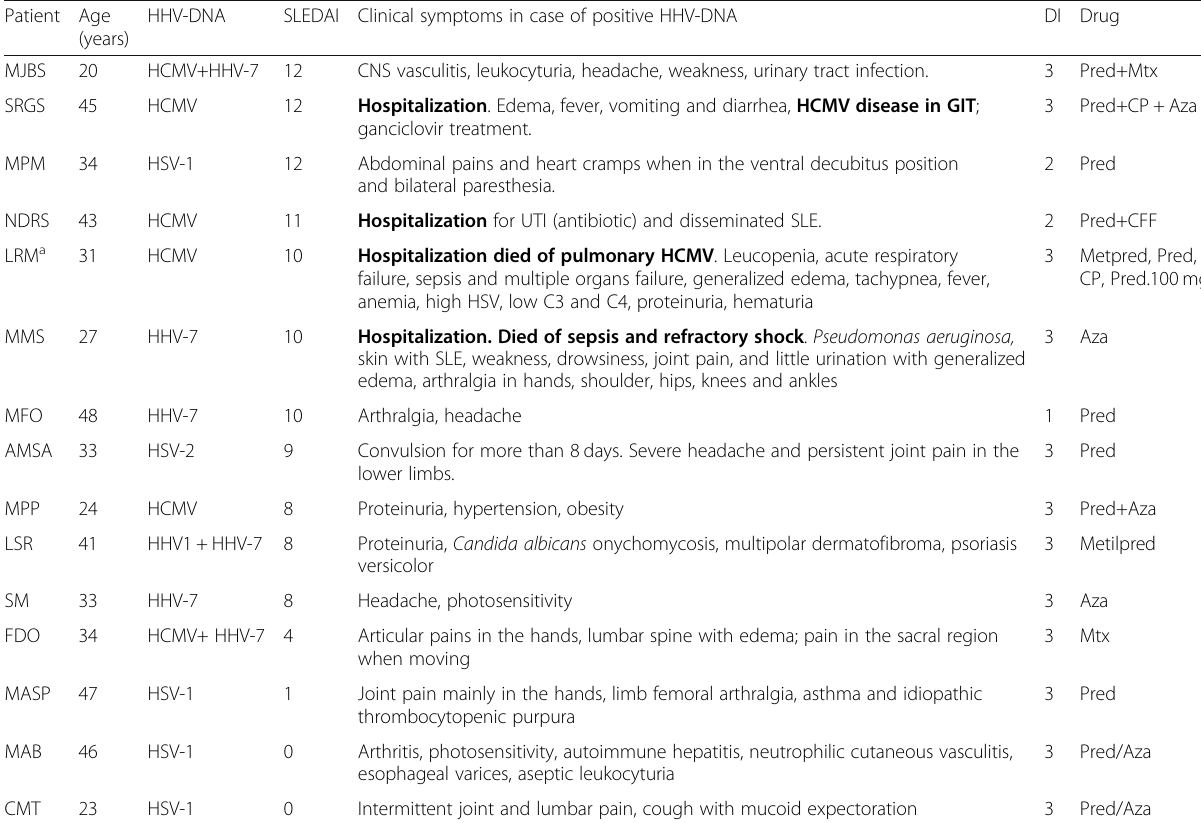
Table 3 Active HHV infection detected via Nested-PCR in the DNA extracted from the serum samples Patient Age HHV-DNA SLEDAI Clinical symptoms in case of positive (years)